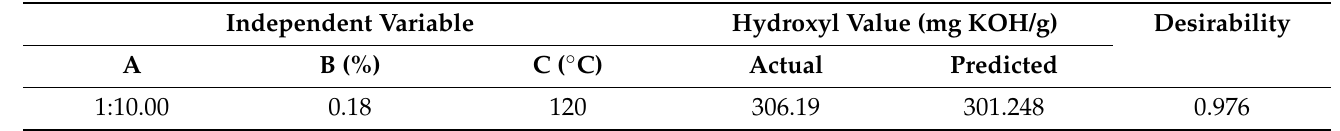
Table 6. Optimum condition for synthesis of